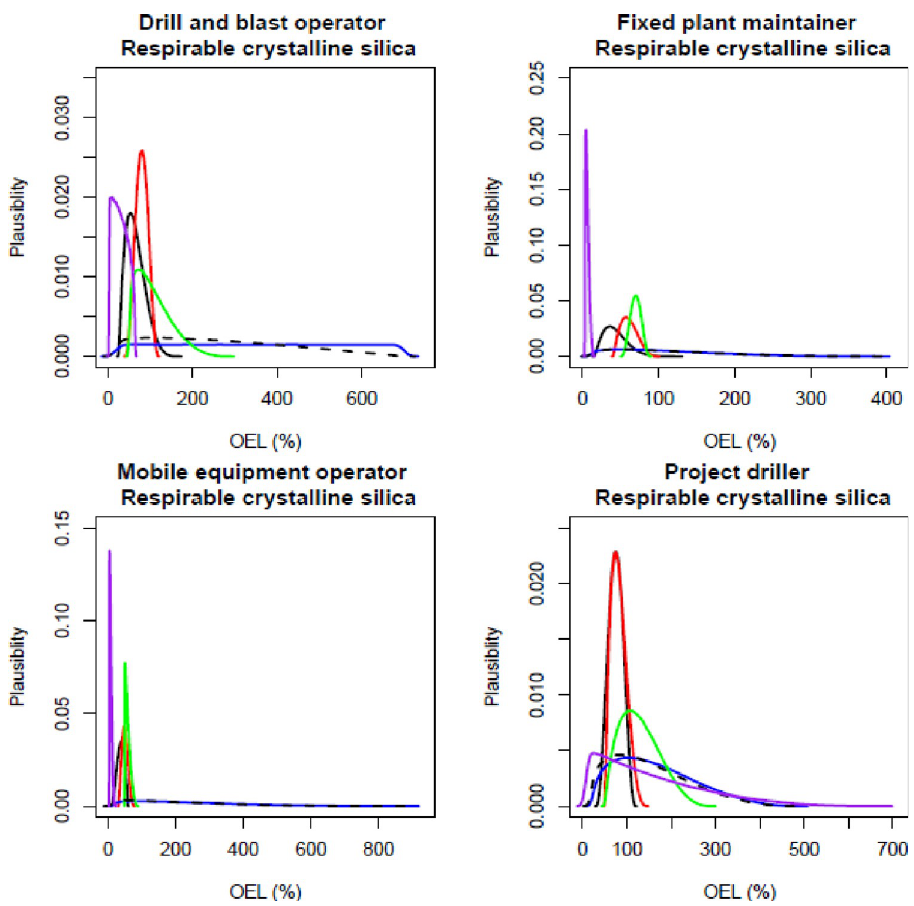
Fig 5. Expert estimates and measured data of respirable crystalline silica percentage of occupational exposure limit (OEL). Each curve depicts the experts support (probability density) or measured data encoded into a scaled Beta distribution. Experts are denoted in the colours blue, red, black and green; combined experts are the dashed line. Measured data is presented as purple.